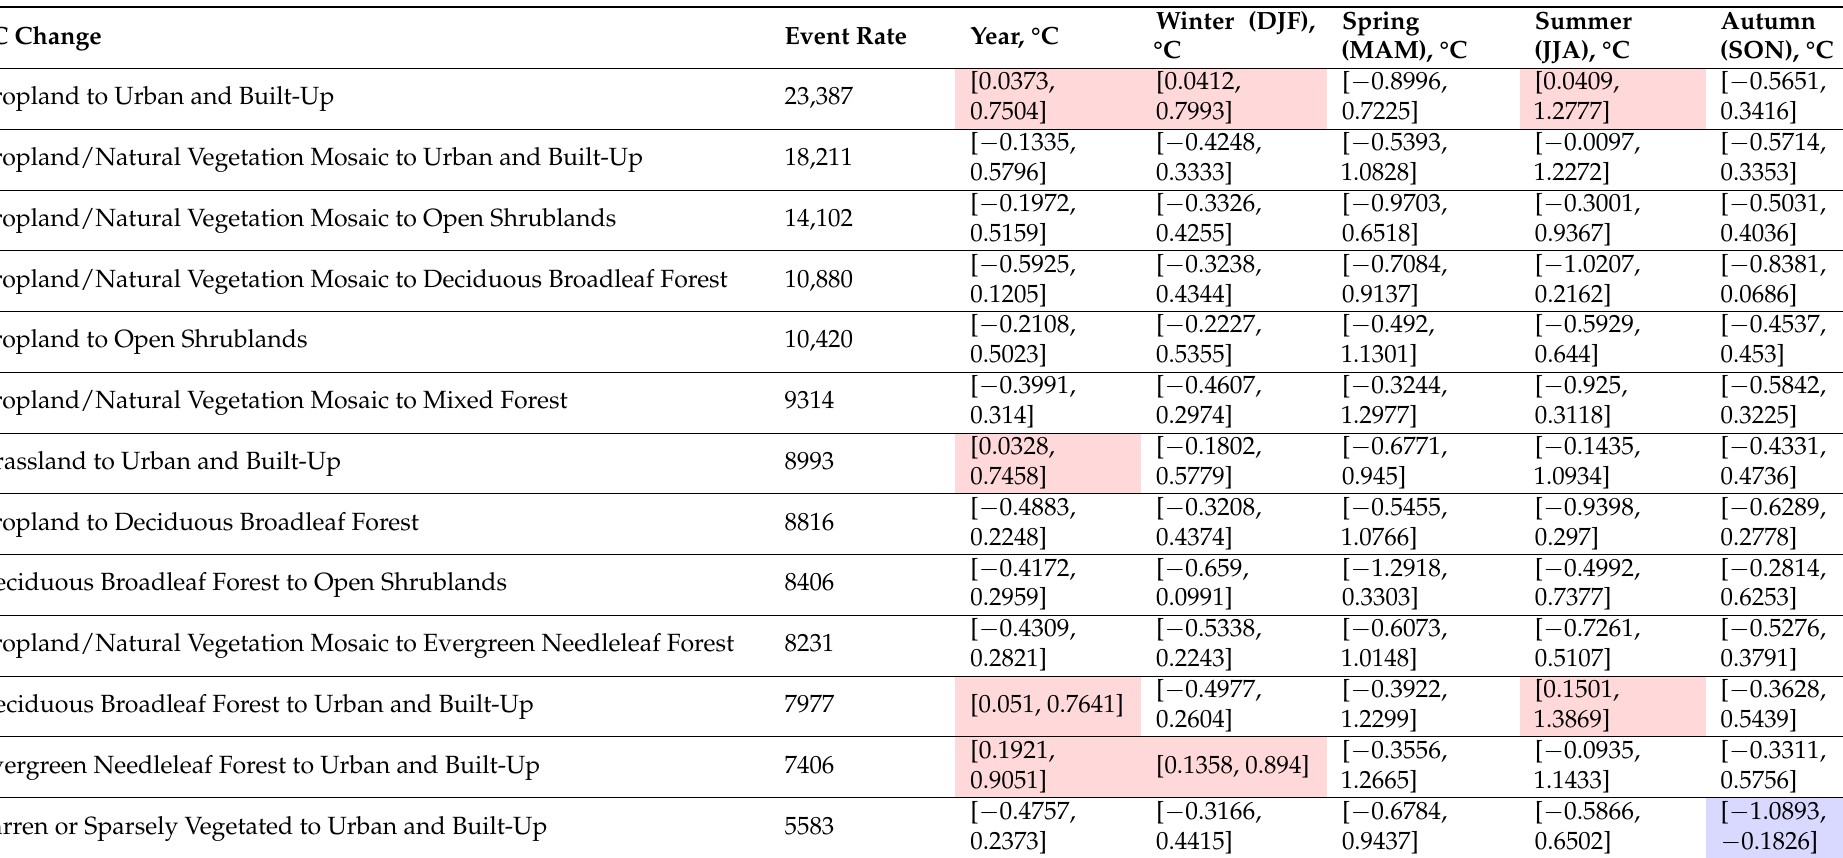
Table A2. Temperature changes in central Europe depending on LC transformation. Blue and red cells represent LC changes resulting in statistically significant cooling and warming, respectively. Intense blue and red cells show cells where LC changes resulted in at least a 0.5 °C temperature change with 95%